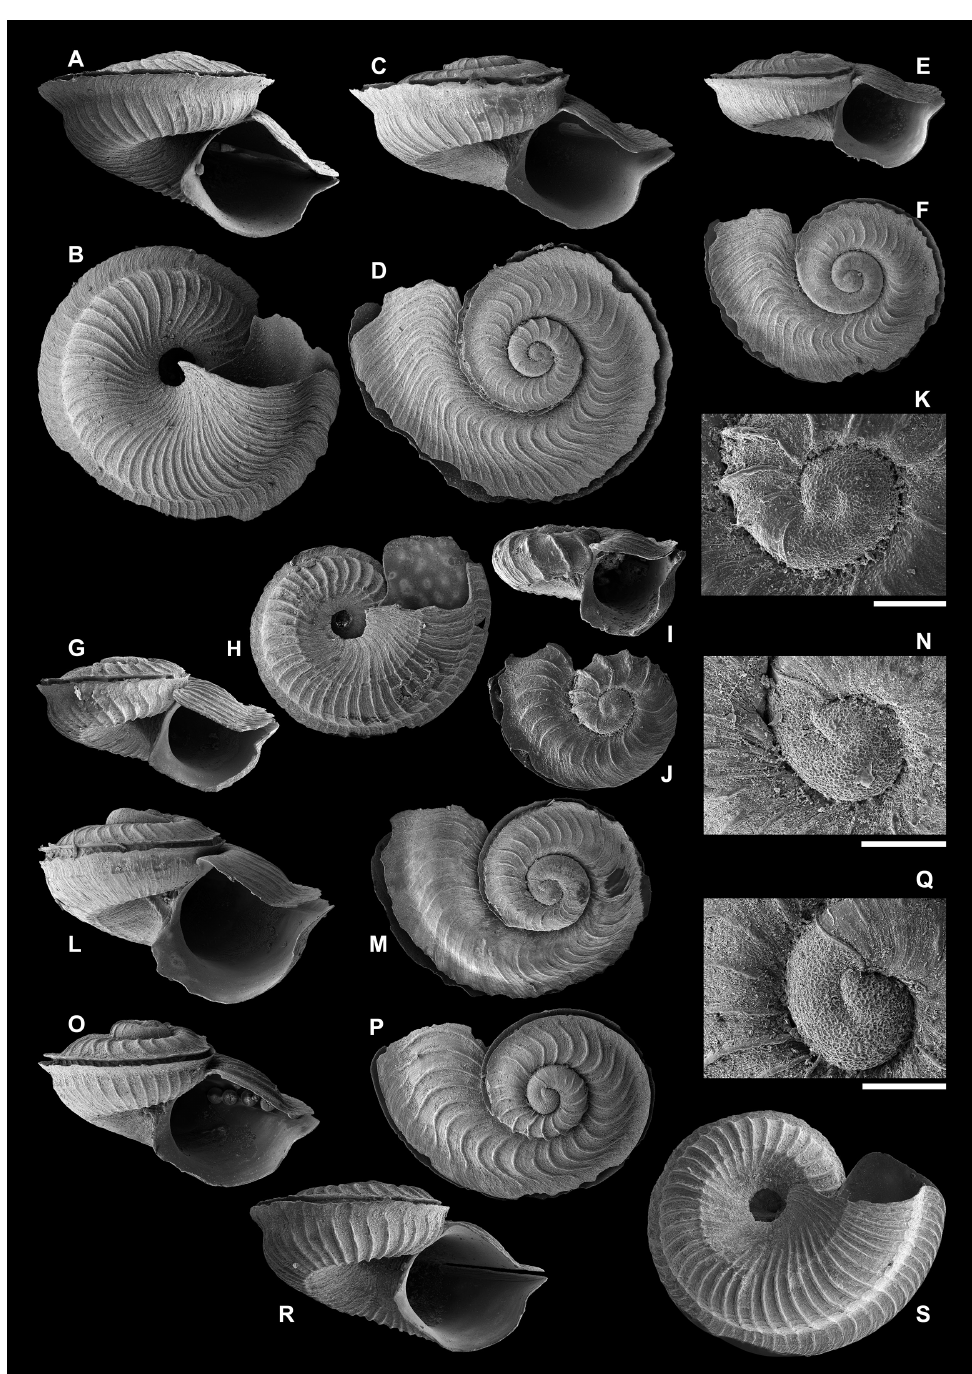
Fig. 3. Anatoma discapex sp. nov. A–F . INDEX19_042RO. A–B . Holotype (SMF 358976), H 1.31